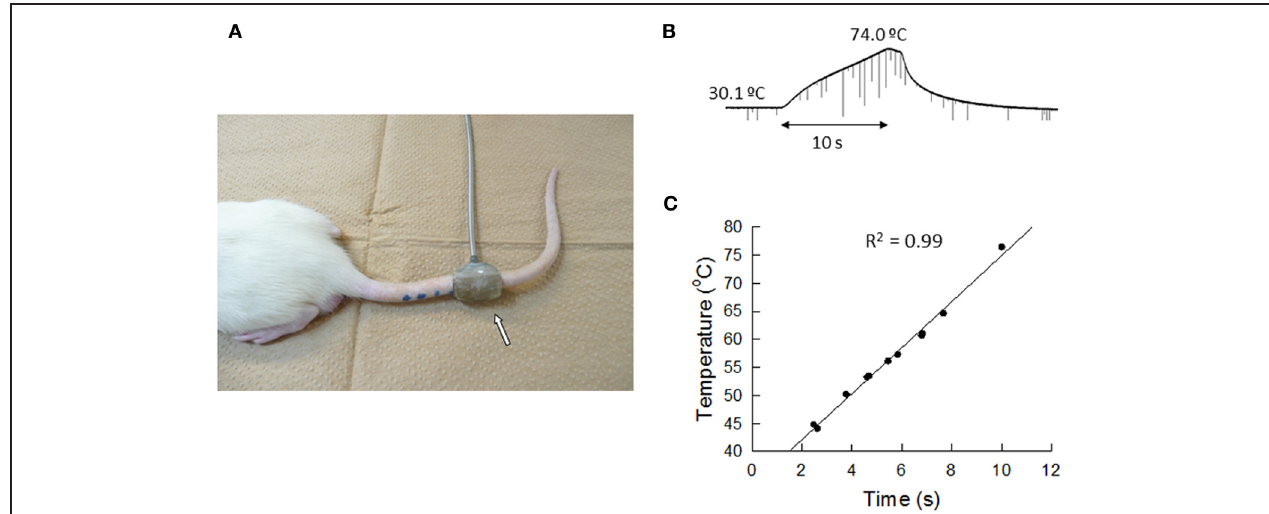
(B) An example of changes in the skin temperature of the tail after the heating was begun. In this case, the skin temperature of the tail before heating was 30.1 ◦ C. After heating was begun, the skin temperature of the tail almost linearly increased to 74.0 ◦ C at 10s. (C) The relation between the skin temperature of the tail and the time from the beginning of tail heating. Eleven points were obtained from 11 untreated rats. Note that a high correlation (R 2 = 0 . 99) was observed between the skin temperature of the tail and the time from the beginning of tail heating (Tsuruoka et al.,